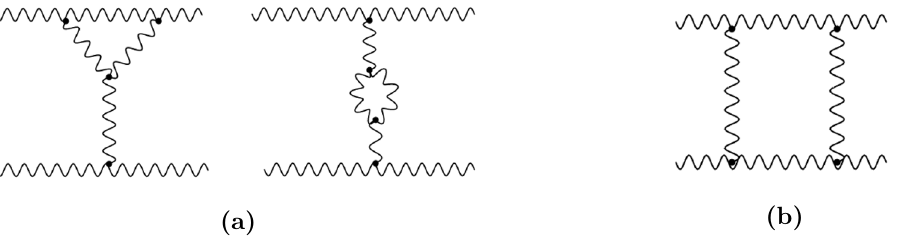
Figure 4. (a): examples of 1-loop corrections to the one-graviton exchange. The wavy lines represent gravitons. (b): example of a two-graviton